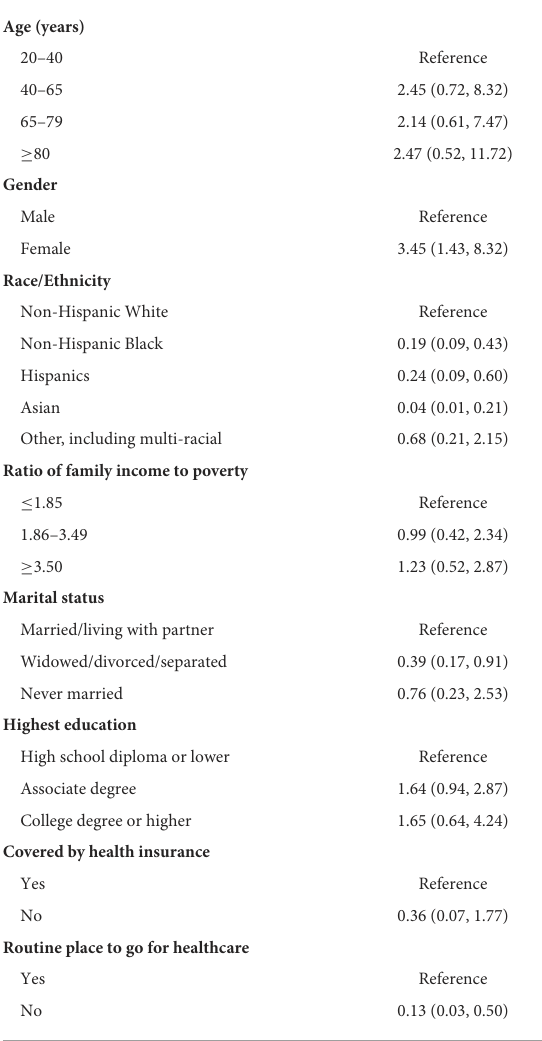
TABLE 3 Multivariate logistic regression of antidepressant use (yes vs. no but with depression diagnosis) in adult cancer survivors in the United